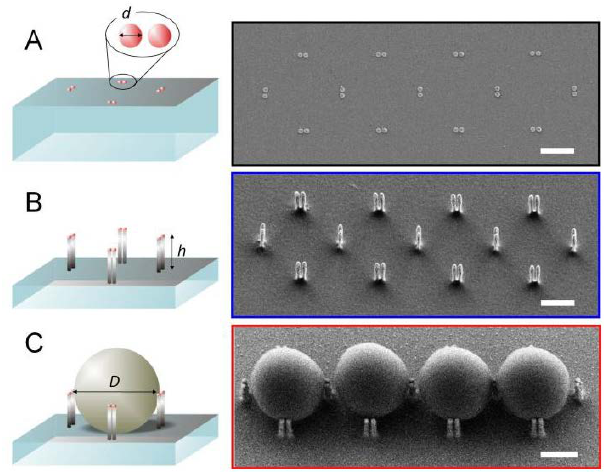
Figure 2: (A) – (C): Schematic outline of the individual steps (left) of the template guided self-assembly for optoplasmonic atoms and molecules, and SEM images (right) of the corresponding hybrid structures. Scale bars are 1 µ m. Reprinted with permission from Ahn et al. ACS Nano 7, 4470 (2013). Copyright 2013 American Chemical